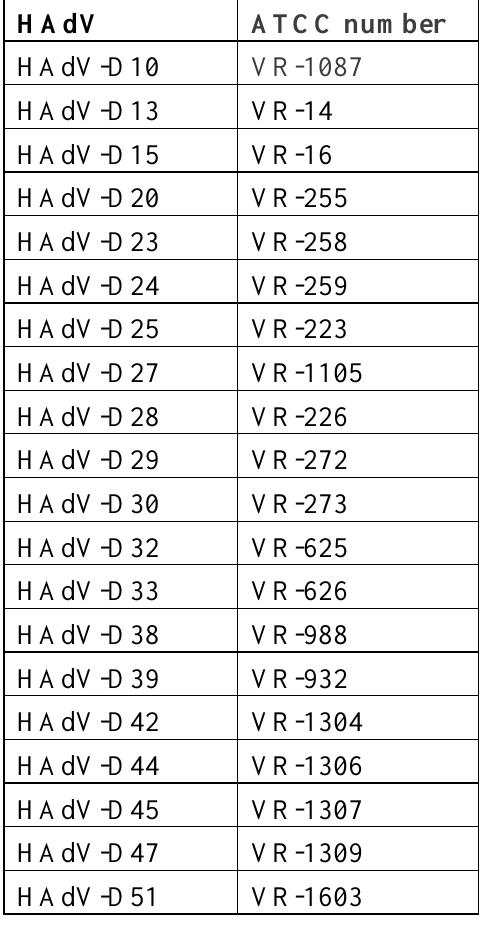
Table 2. Human adenoviruses that have not been completely